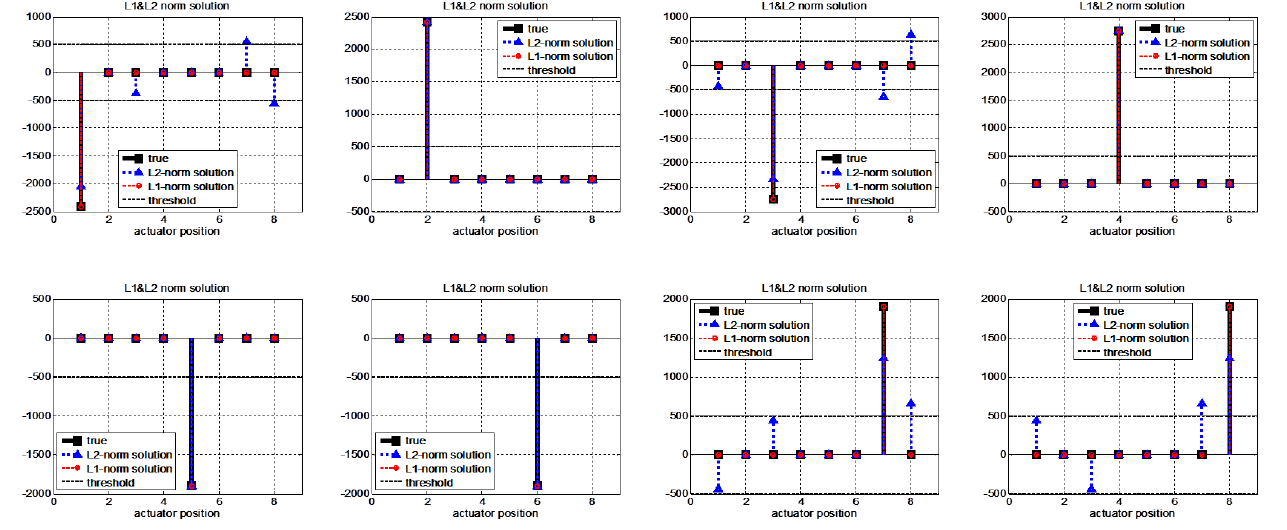
Figure 9. Single fault isolation results for different locations with the (cid:96) 1 -norm and (cid:96) 2 -norm minimiza- tion methods. The true signal indicates the true magnitude of e ( t ) , and the minimal (cid:96) 1 -norm and (cid:96) 2 -norm solution signals indicate the estimated magnitude of e